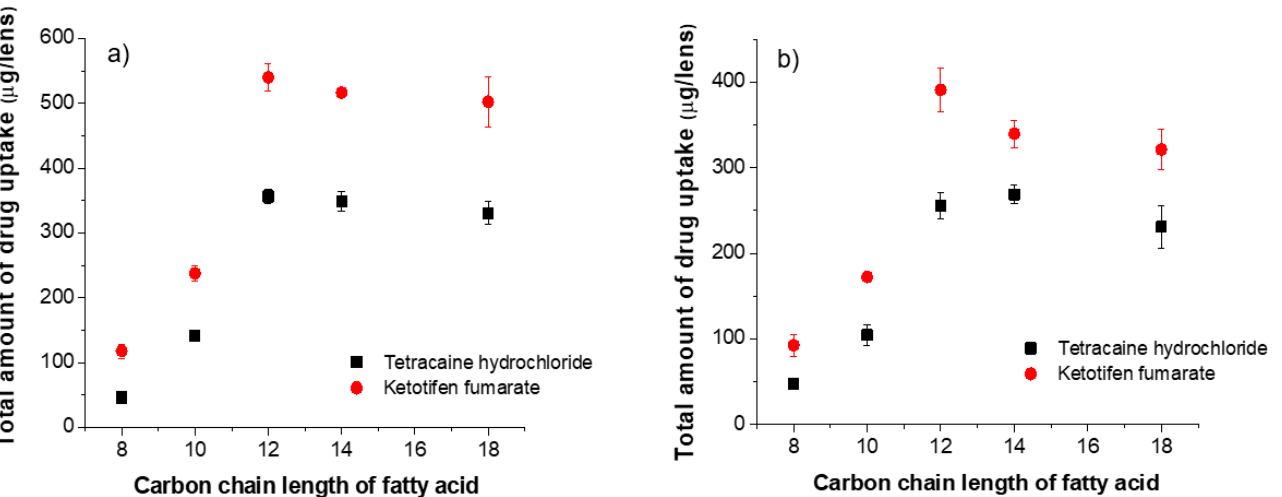
Figure 2. The total amount of drug uptake as a function of carbon chain length of fatty acid. Fatty acids are loaded in silicone hydrogel commercial lenses at a fixed concentration of 25 mM. ( a ) ACUVUE TruEye ® . The total amount of drug uptake for control lenses (i.e., without fatty acid) is: 120.3 ± 4.0 µ g for THCL and 211.1 ± 13.0 µ g for KTF. ( b ) Dailies Total1 ® . The total amount of drug uptake for control lenses (i.e., without fatty acid) is: 99.4 ± 1.7 µ g for THCL and 152.8 ± 7.1 µ g for KTF.